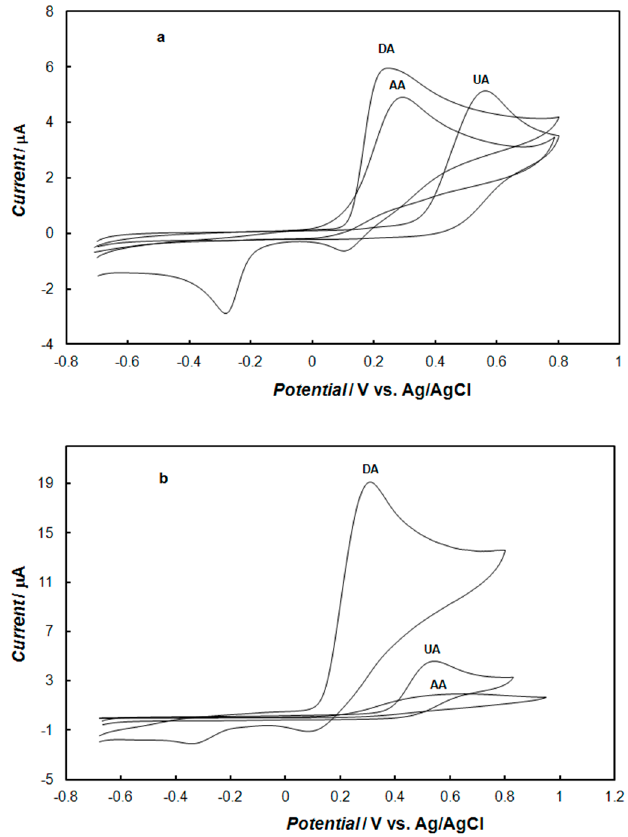
Figure 9. Cyclic voltammograms recorded: ( a ) at the bare gold electrode, ( b ) at the gold electrode modified with the polypyrrole—MCM-48 nanocomposite in 0.1 M of phosphate buffer solution (pH 7.4) containing 1mM dopamine, 1mM ascorbic acid, and 1 mM uric acid The potential sweep rate was 0.1 V s − 1 .